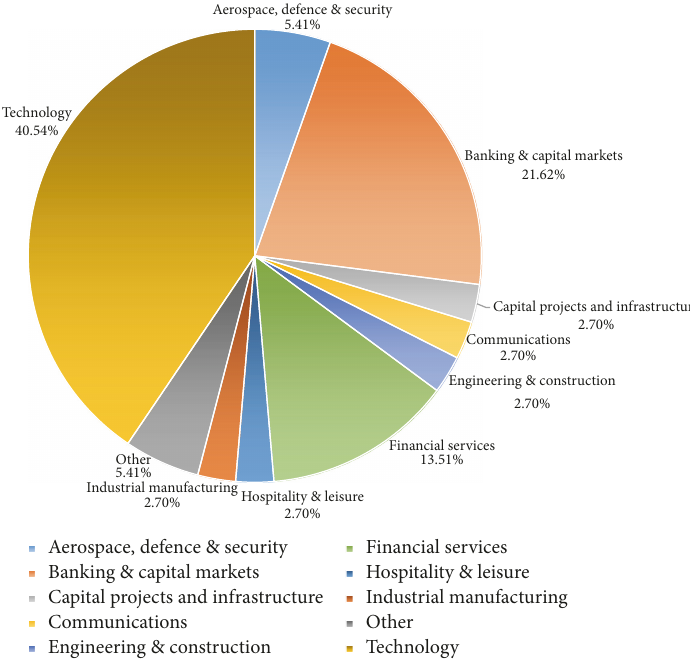
Figure 1: Profile of the respondents. Industrial sector (%).